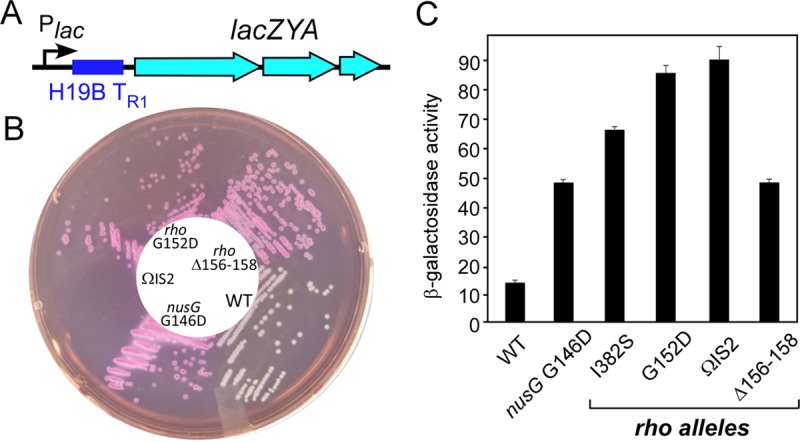
Transcription through a phage H19B TR1 Rho-dependent terminator. (A) A chromosomal reporter with the phage H19B terminator inserted into the leader region of the lac operon. (B) A plate assay on MacConkey lactose agar. The selected rho alleles were moved into the test strain by P1 cotransduction with the ilvC::Kan marker, resulting in strains 404 to 418. (C) Liquid β-galactosidase assay. The data represent the average of three independent experiments ± the standard deviation.